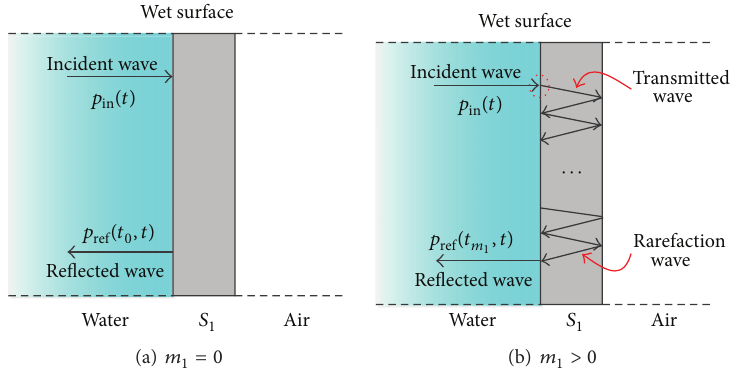
Figure 5: The wave propagation process in the panel: (a) the wave not transmitted into the steel plate (b) the wave transmitted into steel plate once or